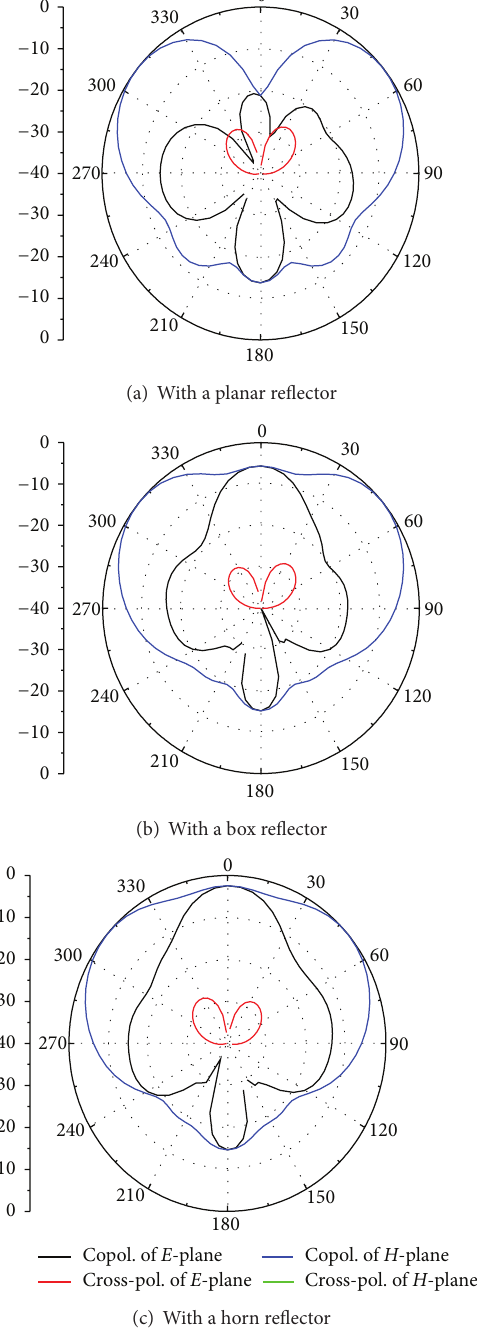
Figure 10: Effects of the reflectors (radiation patterns at 2.7 GHz).